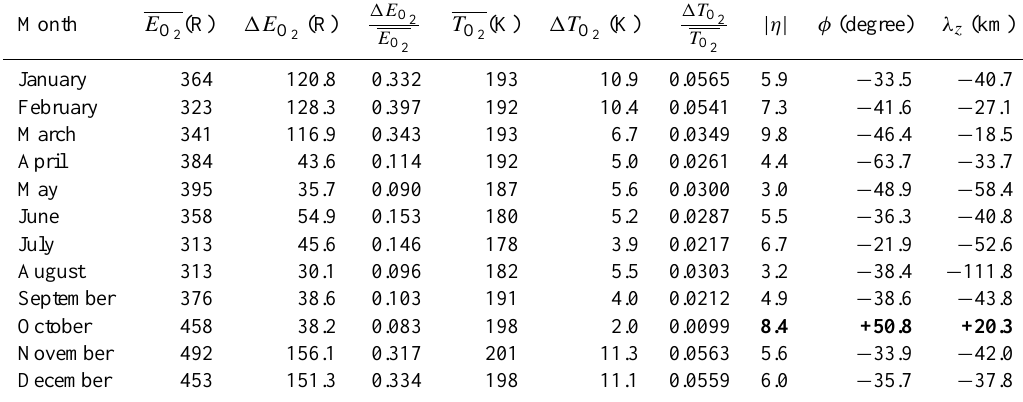
Table 3. Summary of wave parameters from O 2 layer. Solutions obtained from amplitudes smaller than 3K are listed in bold.